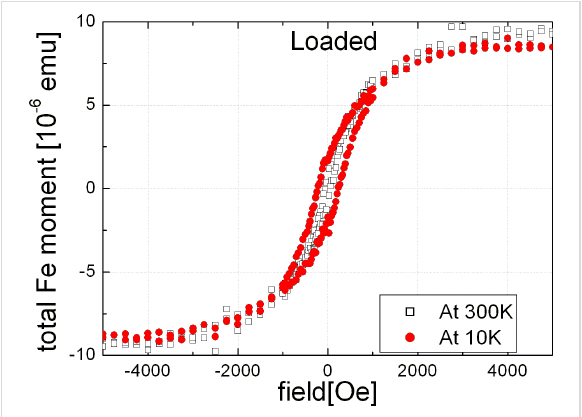
Figure 6: In-plane hysteresis curves of the embedded Fe nanoparti- cles after loading of the Ta substrate with H, measured at 10 K (filled red circles) or 300 K (open squares).